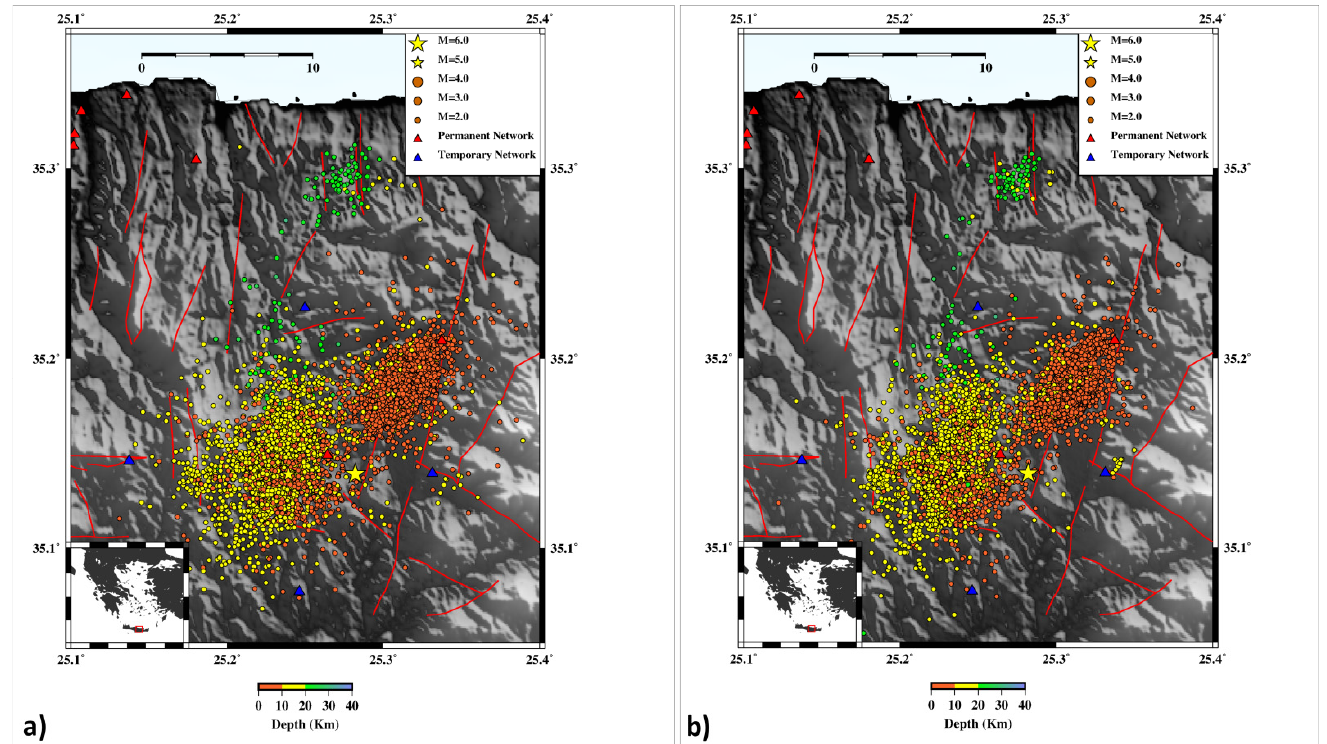
Figure 4. ( a ) Location of the 2021–2022 Arkalochori sequence for 4750 events ( b ) relocated events of the aftershock sequence using hypoDD. The locations of the permanent (red triangles) and the temporary (blue triangles) are presented (see text for details). The M ≥ 4.0 earthquakes are depicted by yellow stars. Faults are marked as red lines (see text and [30] for details).